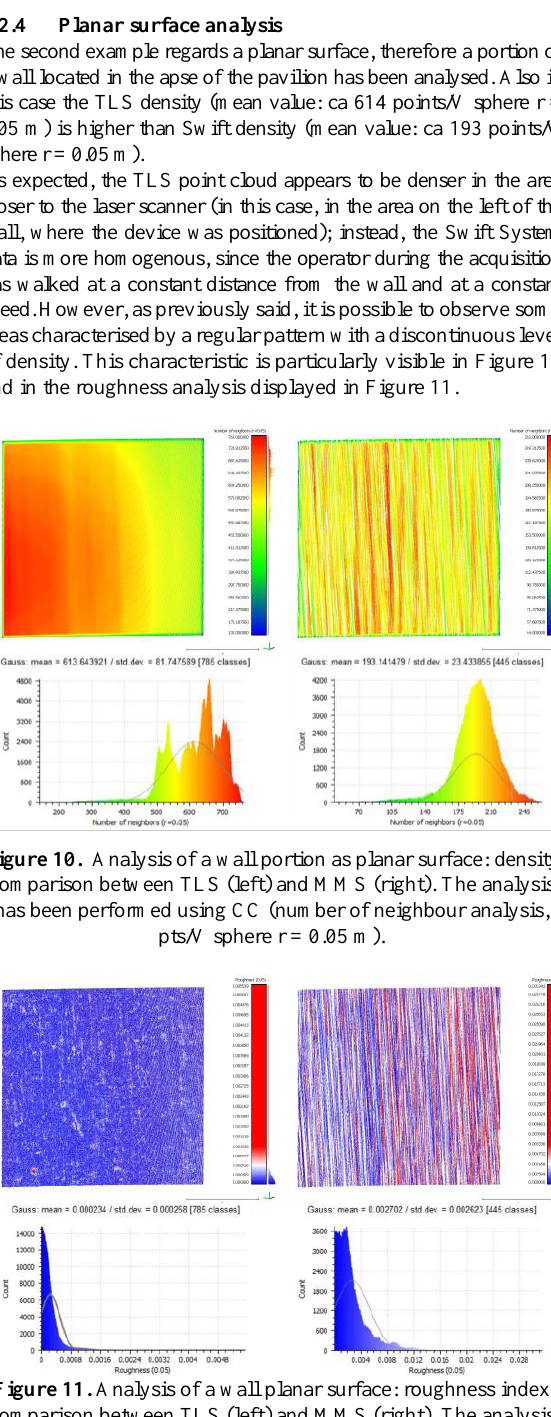
Figure 13. Agnelli bust statue: roughness comparison between TLS (left) and MMS (right). The analysis has been performed using CC (di/V sphere r = 0.05